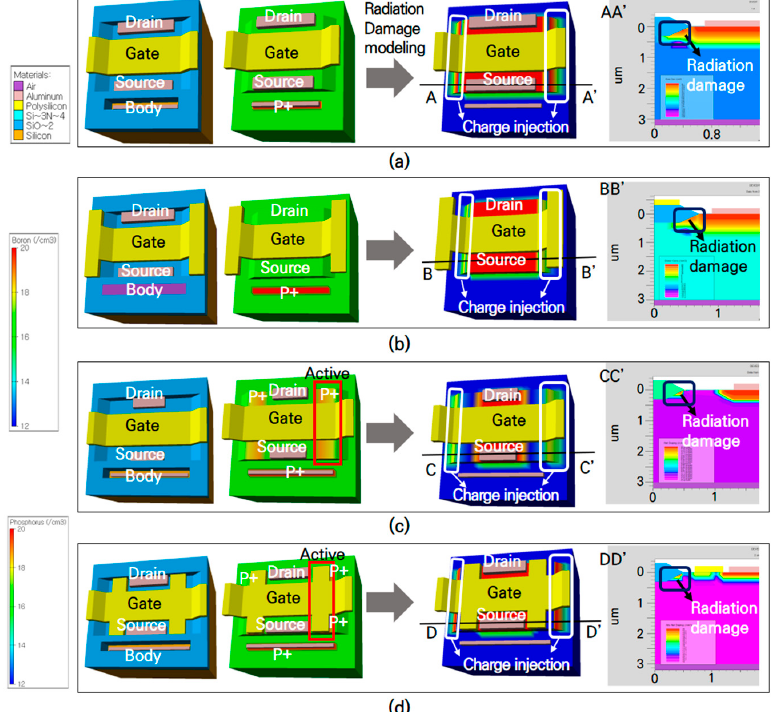
Figure 4. Radiation damage models when radiation-induced interface charges were injected into ( a ) the standard structure; ( b ) the extended gate poly structure; ( c ) the structure to which the p-active and p+ doping regions are added; and ( d ) the combined structure of ( b , c ).